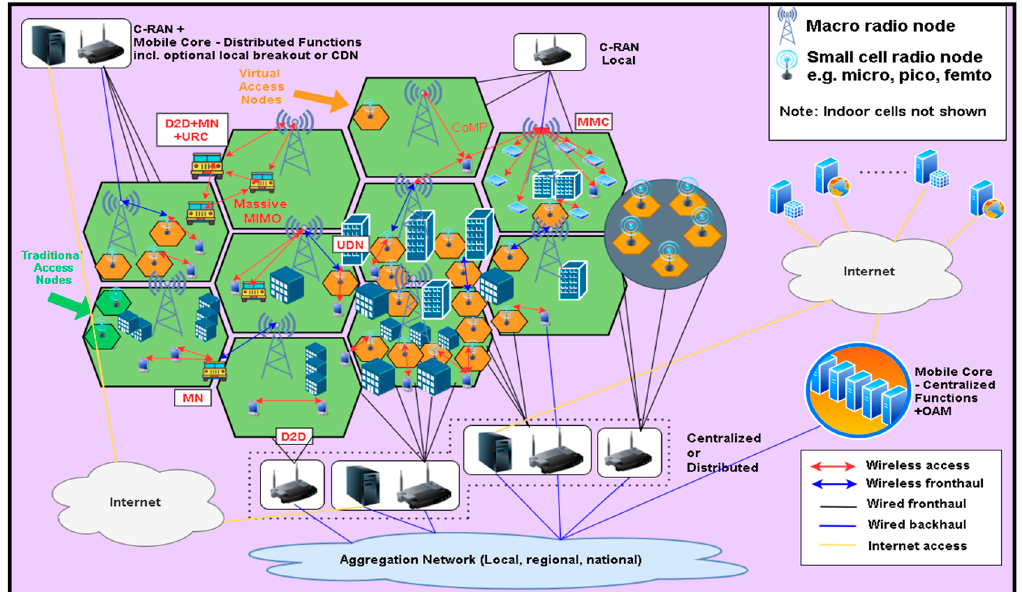
Figure 2. Generic 5G network design (high-level topological view) [41].